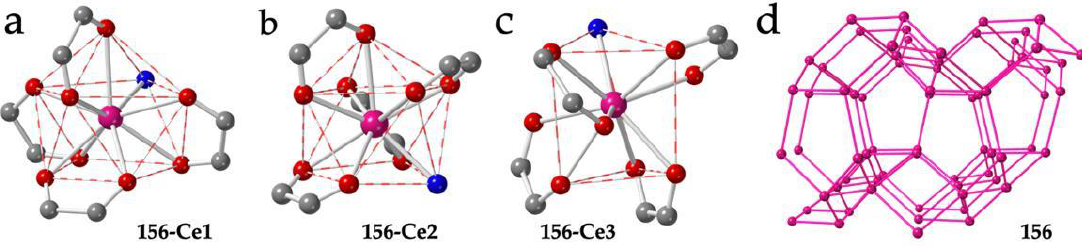
Figure 20. ( a – c ) Coordination environments of the Ce1, Ce2 and C3 ions, respectively, in compound 156 . ( d ) Perspective view of the structure of compound 156 . Pink lines represent the anilato bridges. Colour code: Ln = pink, C = grey, O anilato = red and O water = blue. Finally, compound (PPh 3 Me)[Er(C 6 O 4 Cl 2 ) 2 ] · 1 / 2H 2 O ( 157 ) shows a unique 3D 4,4